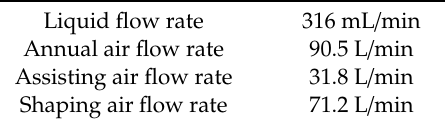
Table 2. Experimental parameters.